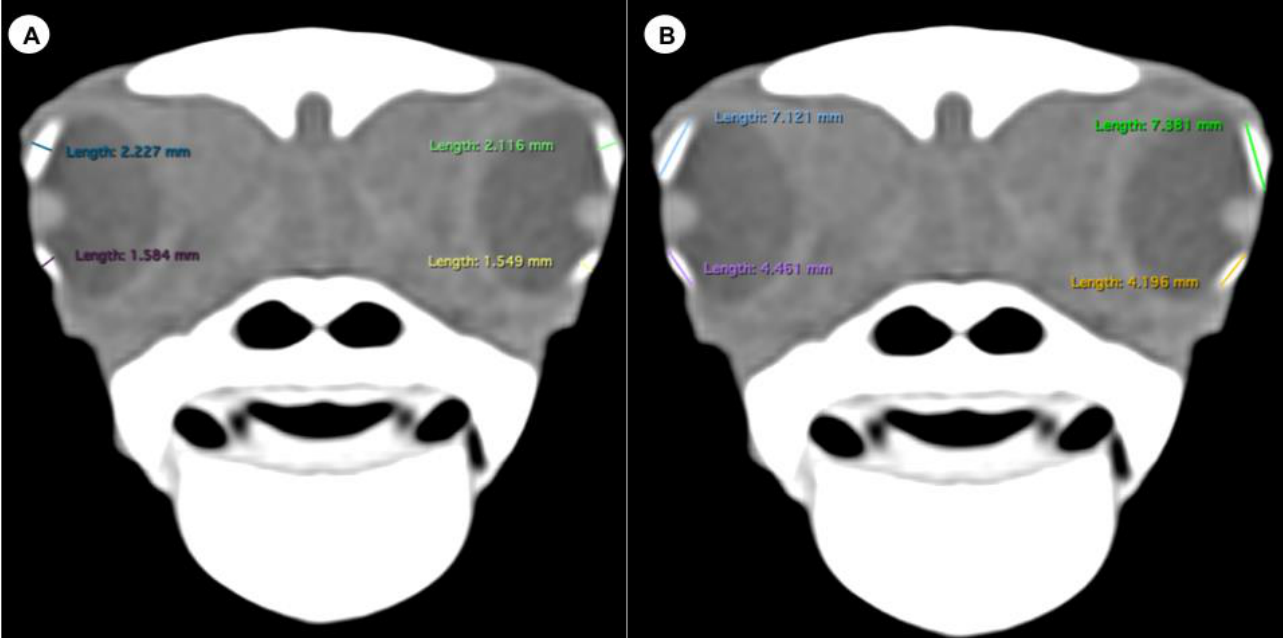
Figure 2. Transverse CT image in soft tissue window of the C. caretta head with the width ( A ) and height ( B ) of the dorsal and ventral arches of the sclerotic ring. - Height of the eyeball or distance between the most dorsal and the most ventral portion of the eye (Figure 3B).